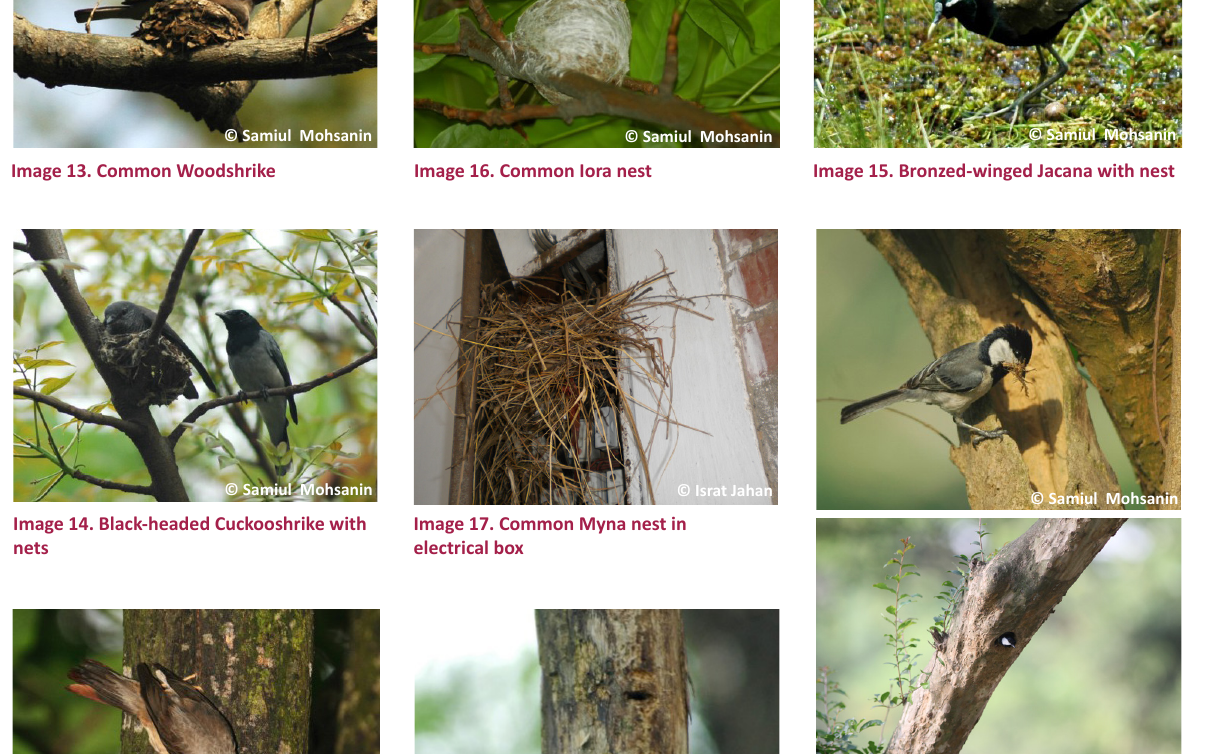
Image 18. Great Tit